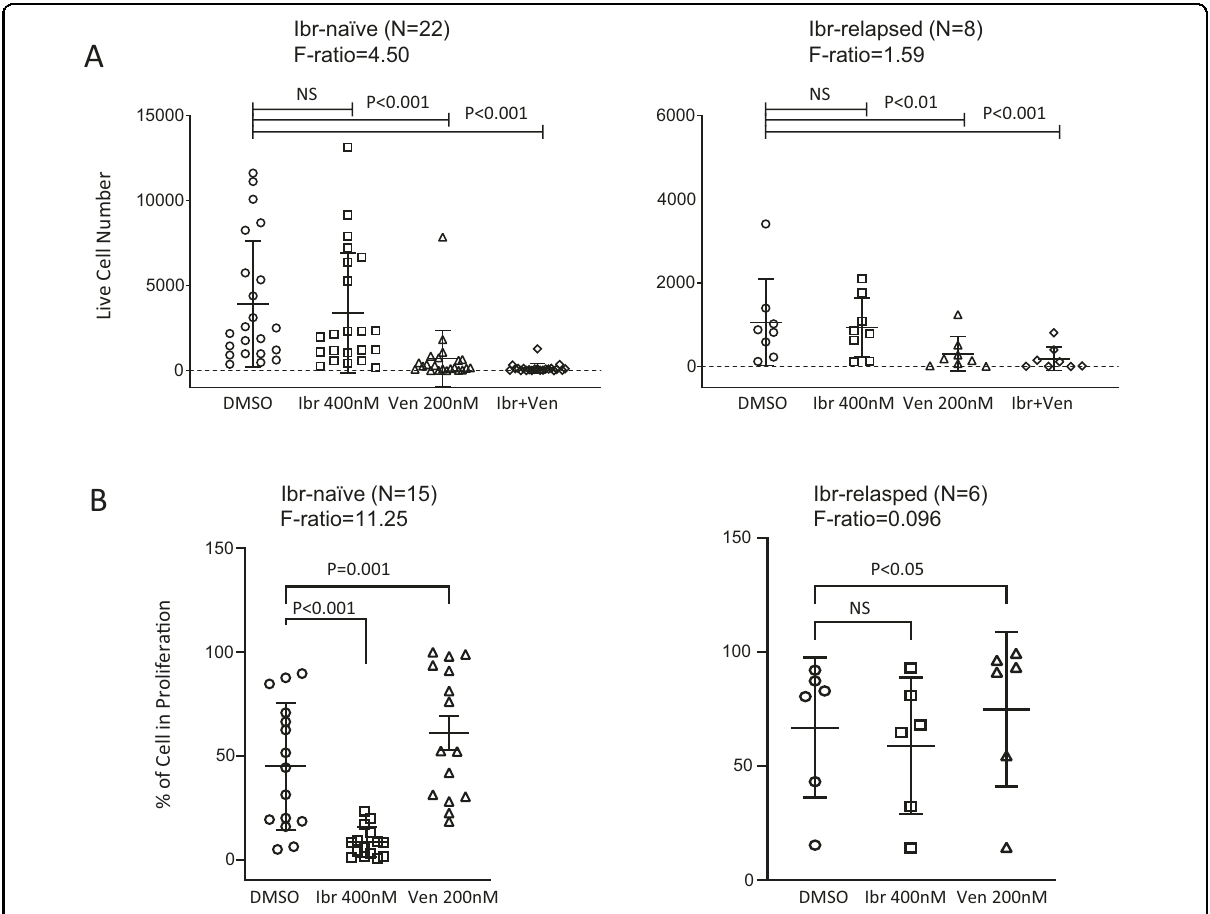
Fig. 6 Effects of ibrutinib, venetoclax or combination on cell viability and cell proliferation. A Aggregate results of cell viability for ibr naïve patients (left) and ibr resistant patients (right). B Aggregate results of percentage of the dividing CLL cells for ibr naïve patients (left) and ibrutinib- resistant patients (right). The combination was not depicted since analyses of the CFSE pro fi les became less meaningful in many cases due to the small number of residual live cells left after the combined treatment. p values and F ratios are